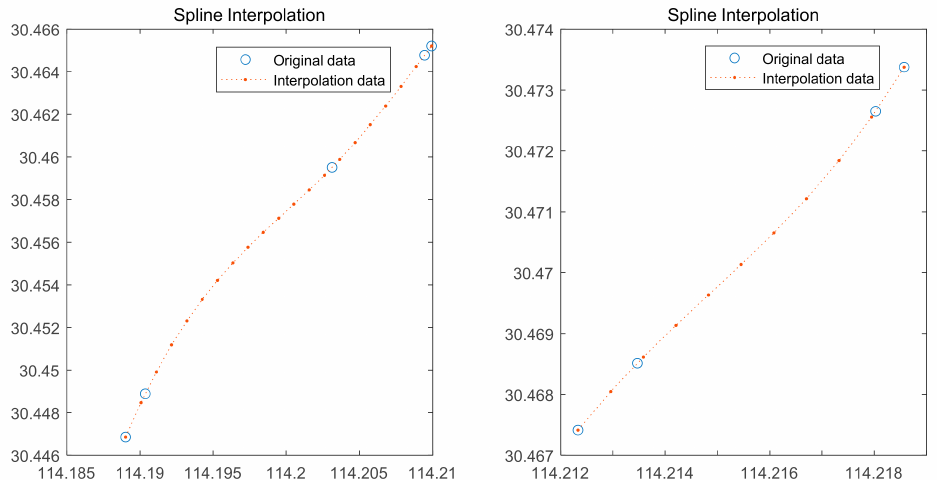
Figure 5. Cubic spline interpolation results.